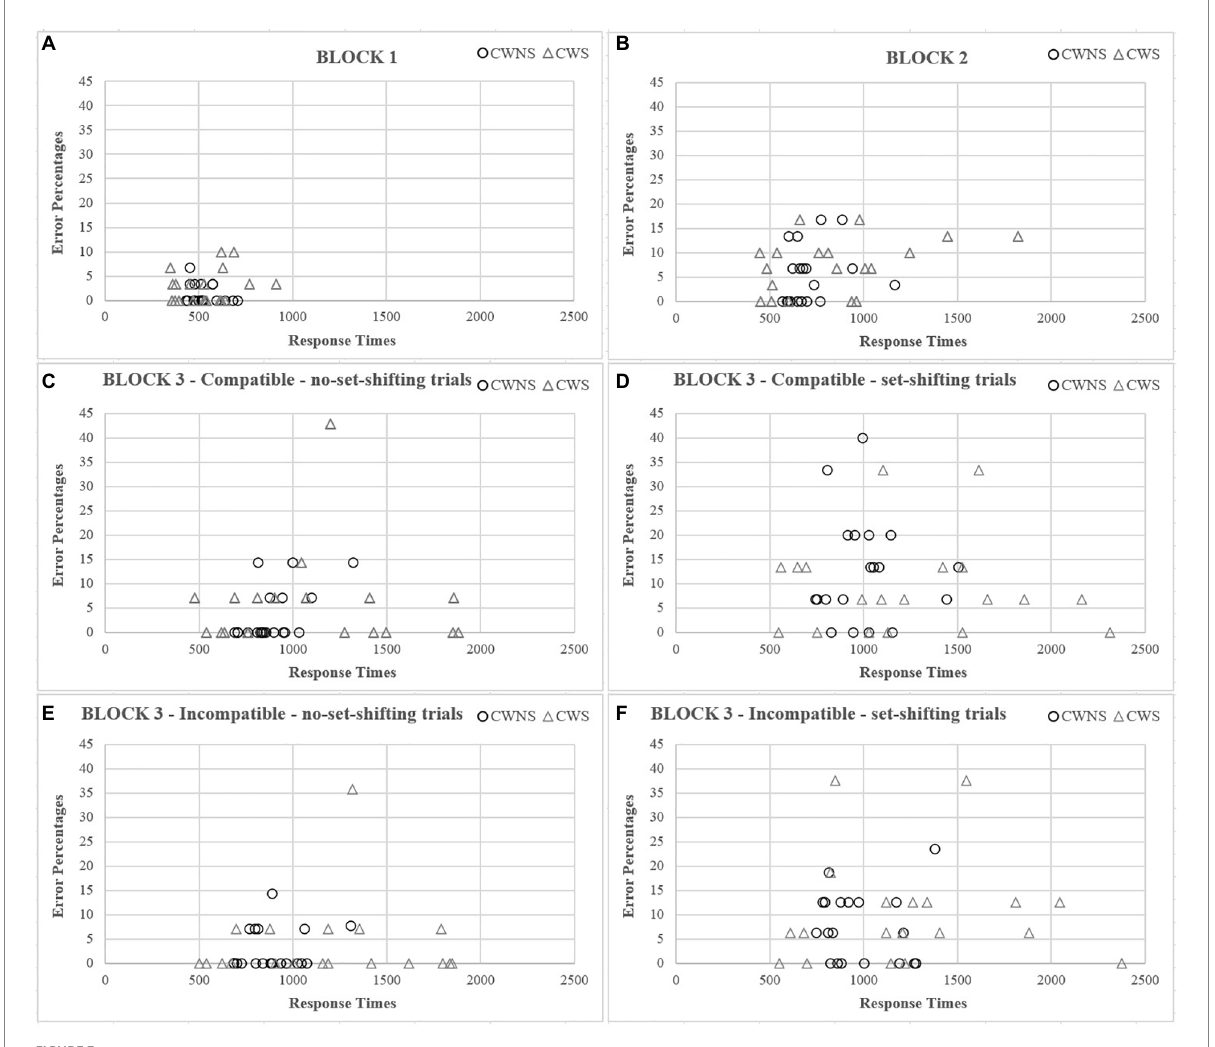
FIGURE 3 Scatterplots between speed and accuracy as a function of group for each block (A, B) and breakdowns of the mixed block (C–F)